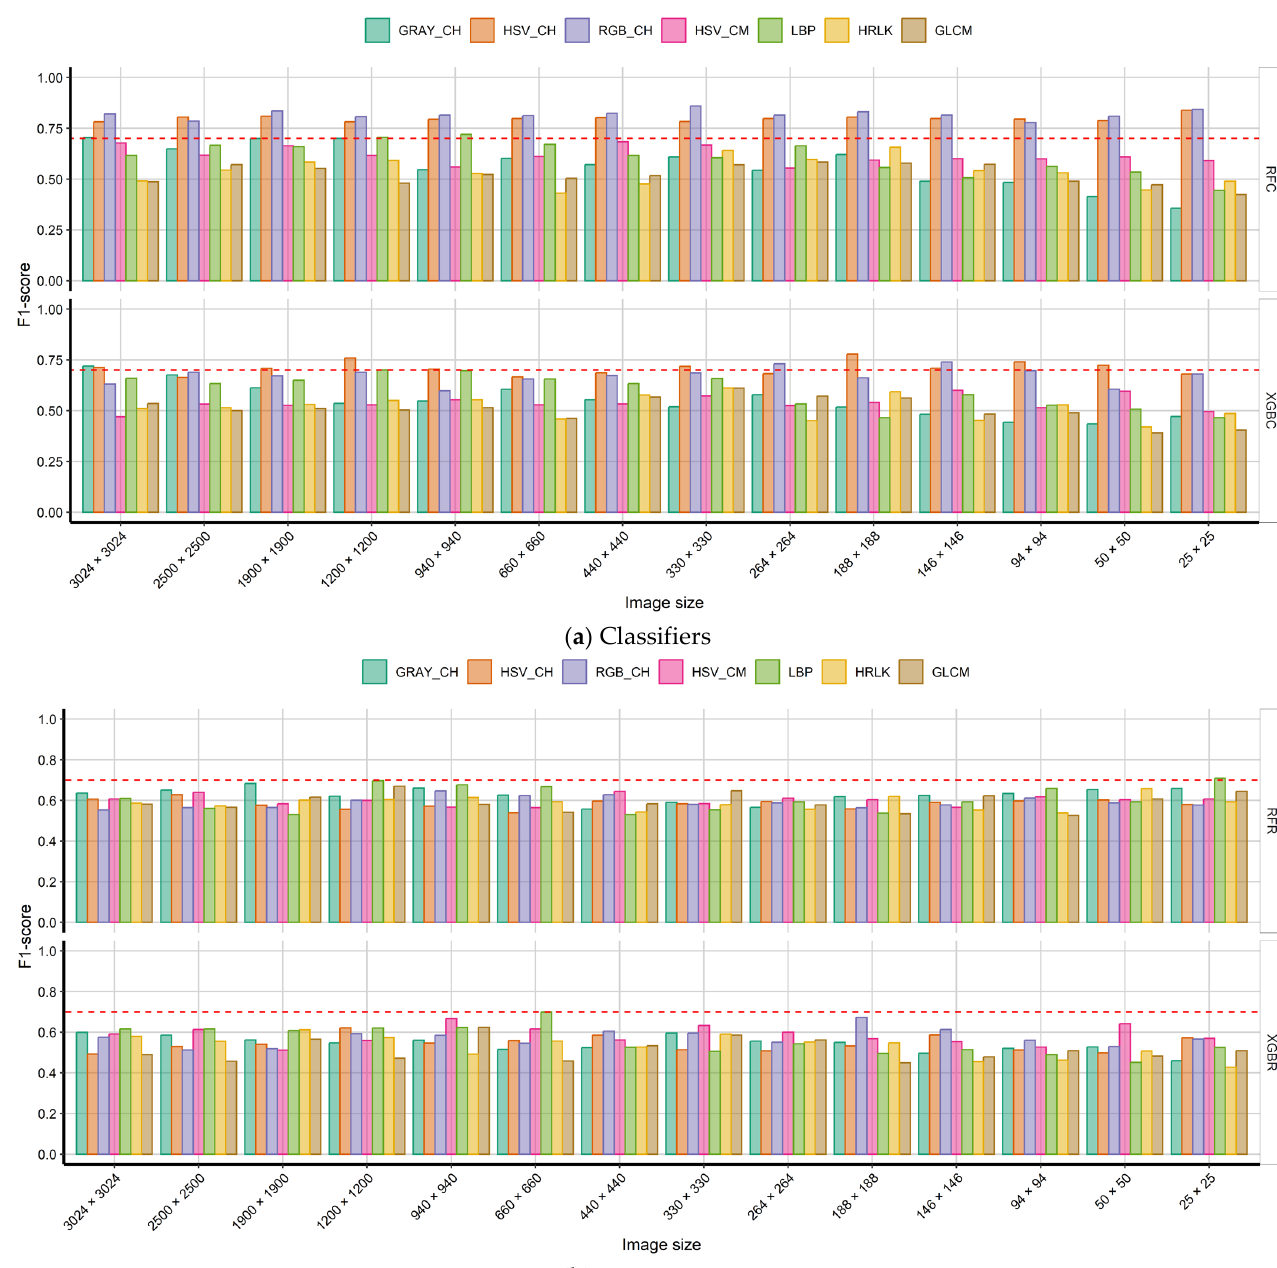
Figure 6. F1-score average performance with global descriptors between classifiers and regressors while cropping the images in dataset G01.